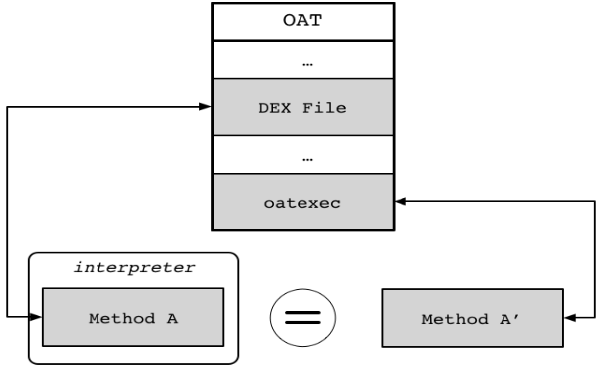
Figure 10. Dalvik bytecode and machine code in OAT .